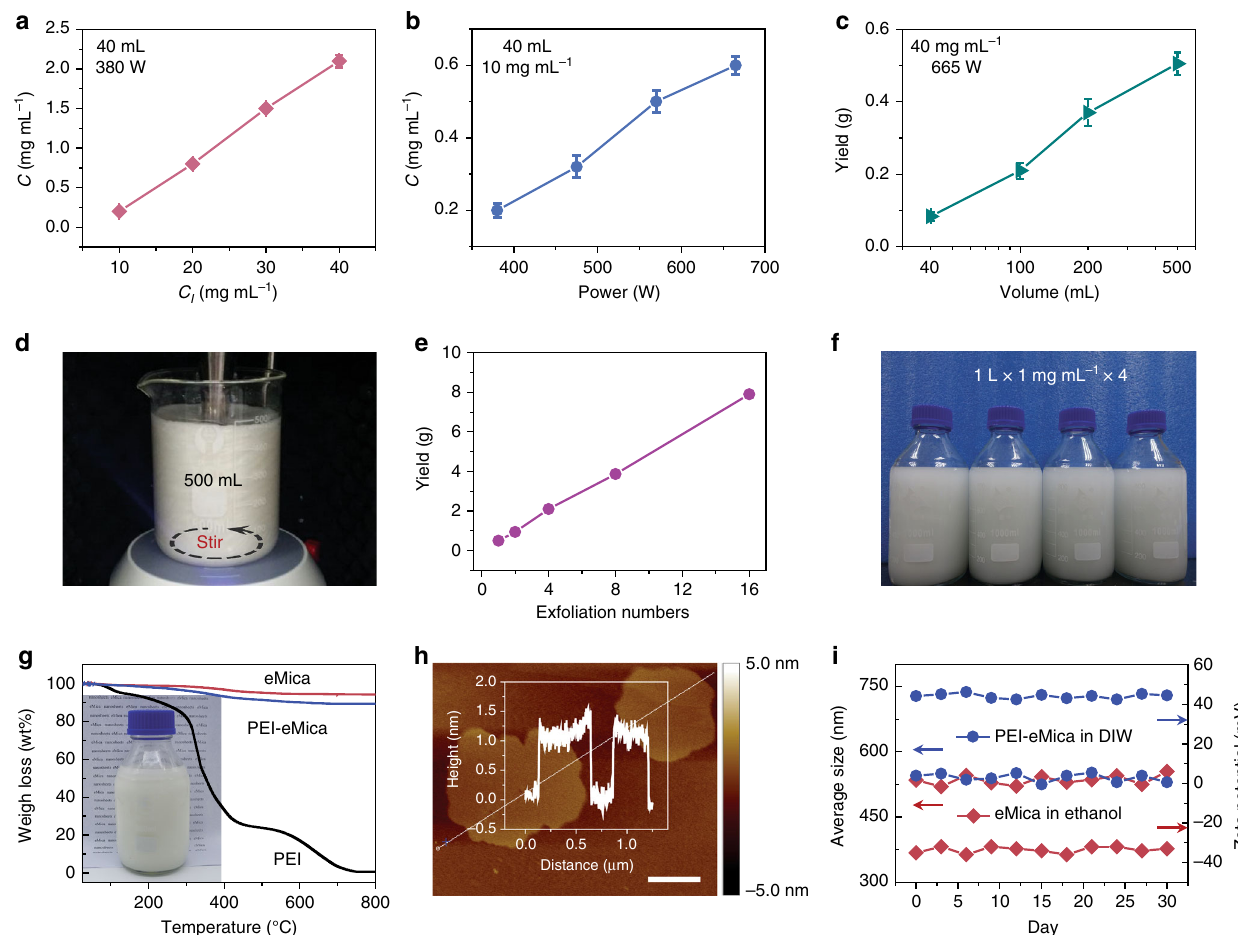
Fig. 2 Large-scale exfoliation of ground mica into eMica nanosheets. a Concentrations ( C ) of eMica nanosheet dispersions prepared by 30 min ultrasonication treatment (380 W) of 40 mL of intercalated mica dispersions with different initial concentrations ( C I ). b Concentrations of